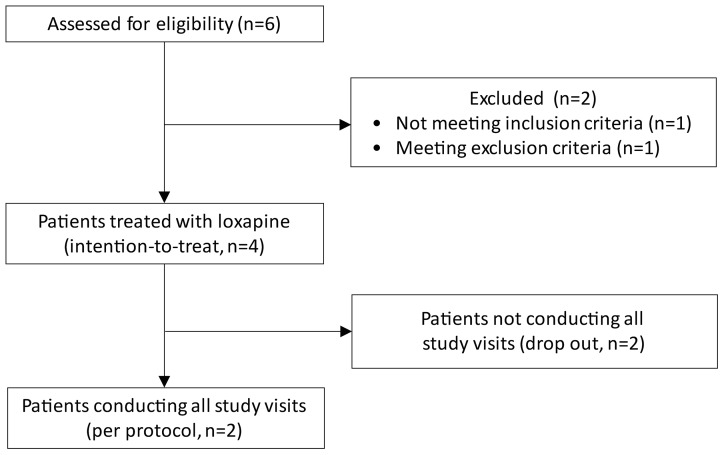
Study flow chart.